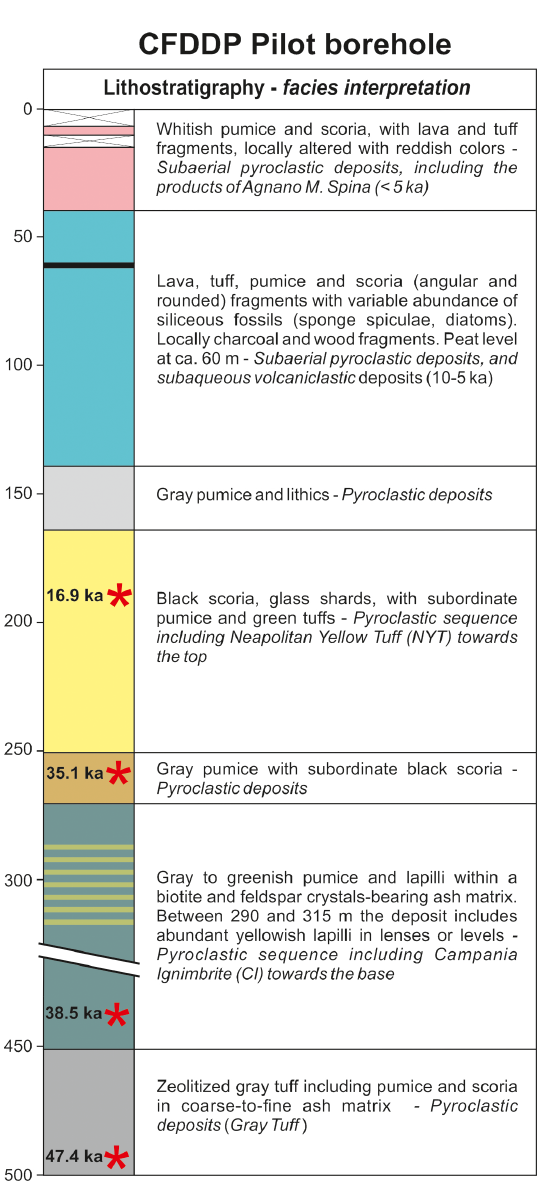
Figure 8. Synthetic lithostratigraphy and facies interpretation of the succession sampled at the CFDDP pilot borehole (500m) on the shore of Bagnoli in 2012 (modified after De Natale et al., 2016). Red asterisks indicate the depth and 40 Ar / 39 Ar age of sampled K feldspars. See Figs. 2–3 and 6 for the location of the borehole